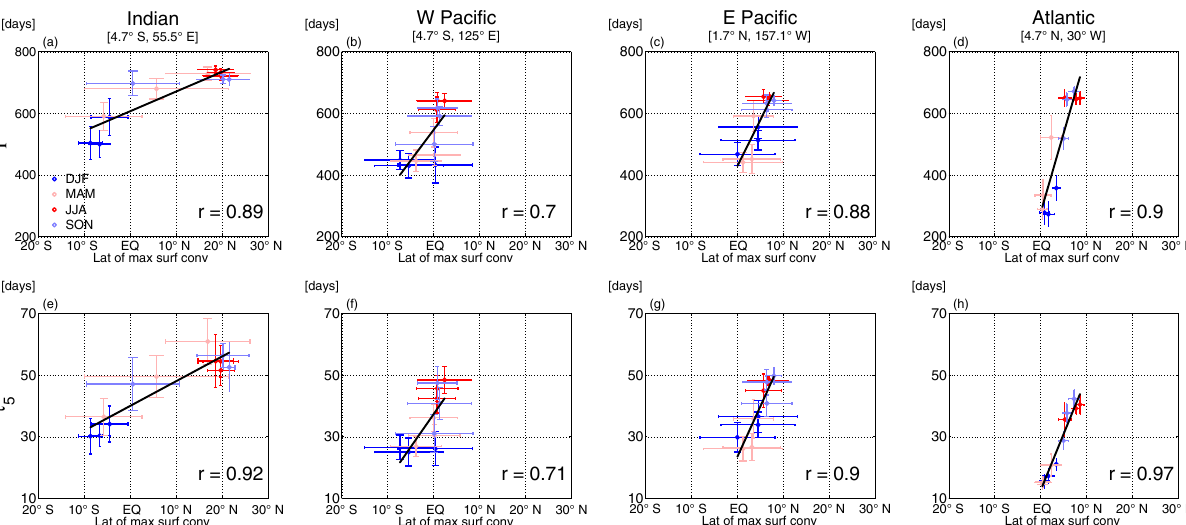
Figure 6. Relationship between the latitude of maximum surface convergence and tracer age at 900 Pa for locations in the (a, e) Indian, (b, f) western Pacific, (c, g) eastern Pacific, and (d, h) Atlantic oceans. Top row shows (cid:48) and bottom row τ 5 . Coordinates of the locations are shown above (a) – (d) . Width of the horizontal or vertical bars are twice the interannual standard deviation, and different colors represent different seasons (see a ). Black line shows linear fit, and correlation coefficient is given within each plot.